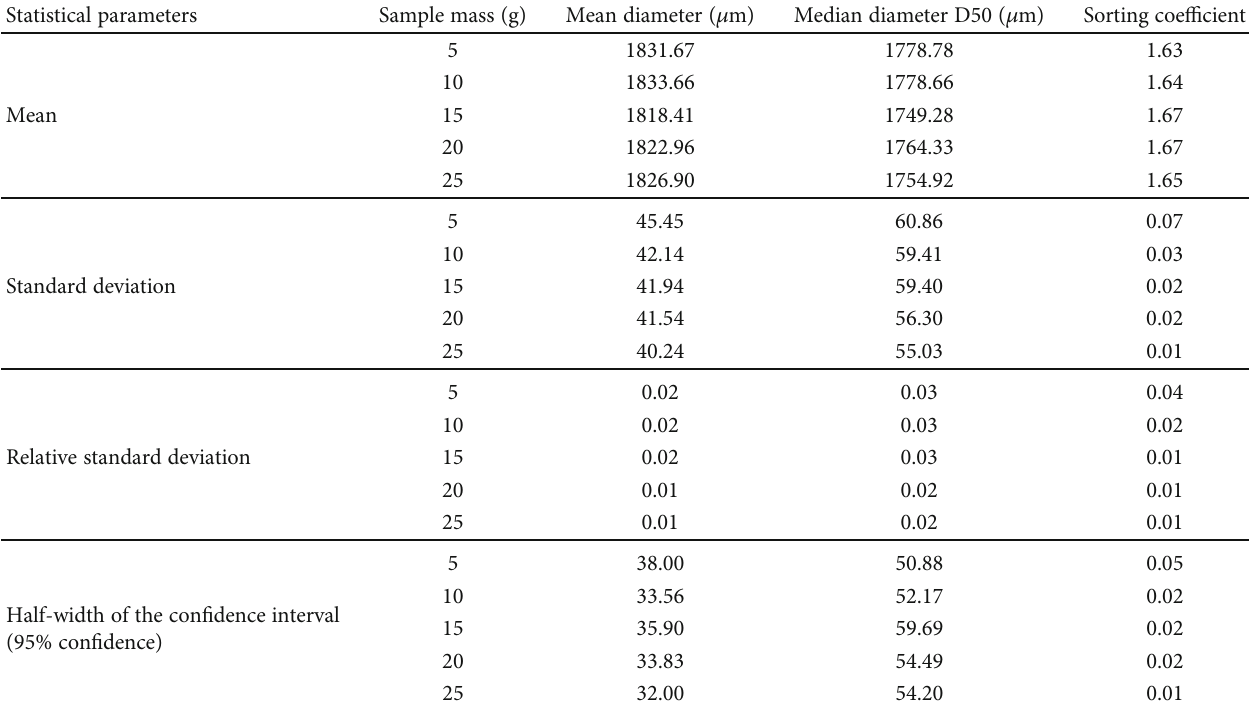
Table 2: Statistical parameters of the PSD characteristics of 8 times repeated experiments with di ff erent masses (coal sample C1, mass = 5 g ~ 25g).